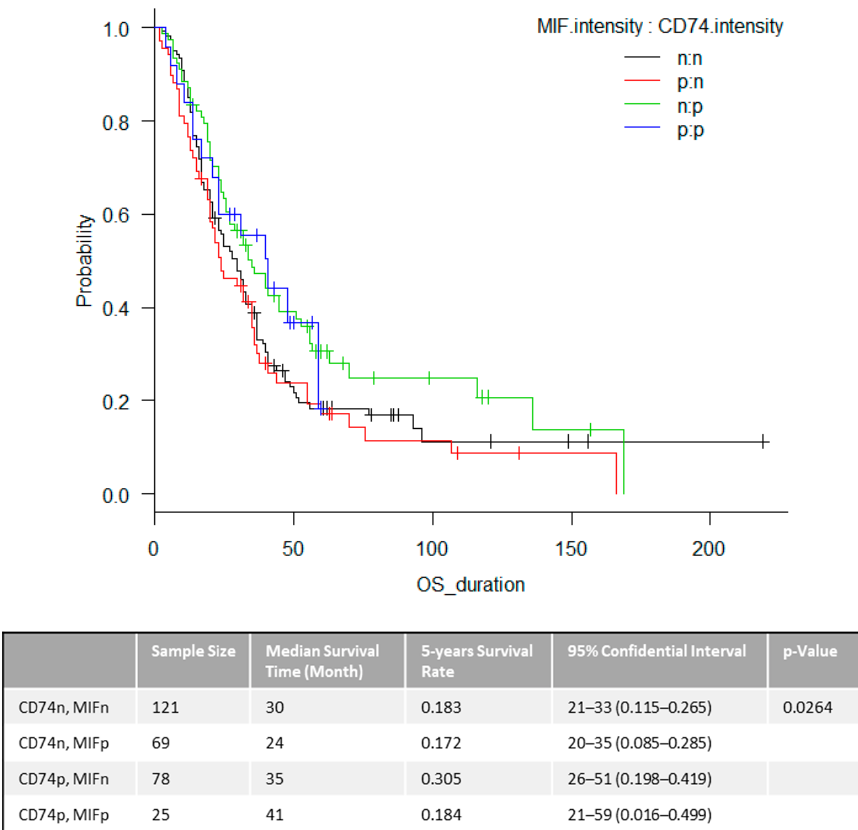
Figure 2. Overall survival for combined markers. Clinical outcomes by combined markers of CD74 and MIF in tumor cells in stage IV melanoma patients in datasets. Kaplan-Meier analysis for OS for their expression by intensity of staining. n = negative (no staining), p = positive (light to intense level of staining).